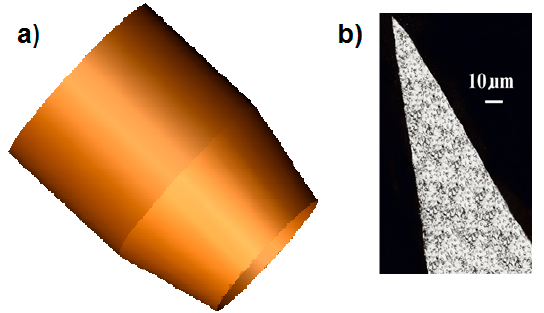
Figure 8. The cylindrical cutting blade for finishing the machined surface by longitudinal scarfing. ( a ) cutting end, ( b ) detail of the cutting edge.